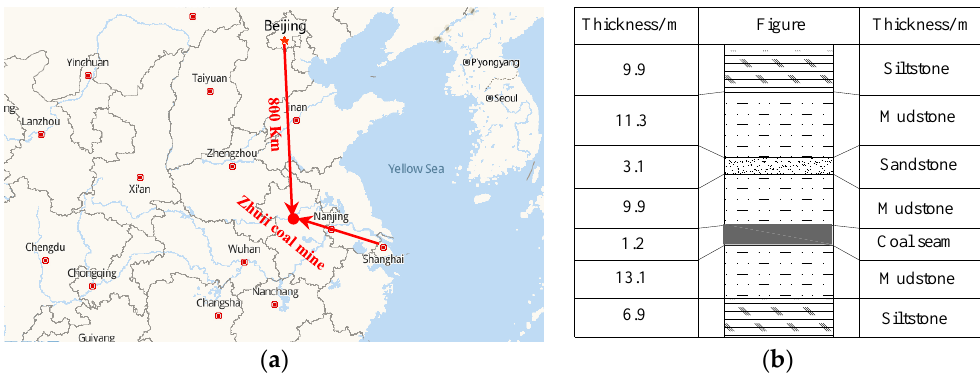
Figure 1. Location of the target coalmine ( a ); and Geological columnar section ( b ).